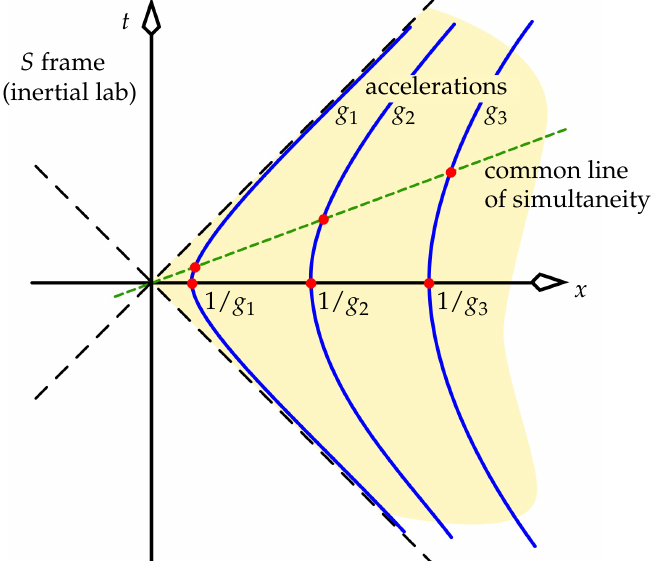
Figure 2. Three of the continuum of observers who help us make measurements. When their accelerations in their MCIFs bring them momentarily to rest at positions given by those accelerations’ reciprocals (really c 2 / g 1 , etc., in conventional distance units), then the geometry of hyperbolae guarantees that these observers will always share a common line of simultaneity, as required to make a well-defined frame. This frame covers only the quarter of spacetime shaded yellow. The bunching up of the observers in the future and past (times when they move quickly) is the Lorentz